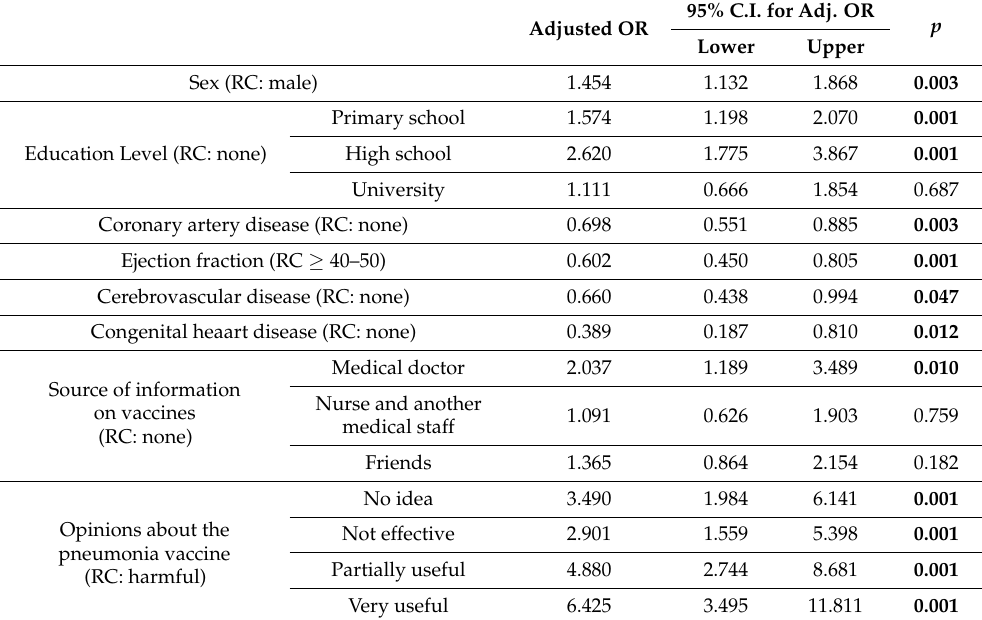
Adjusted effects of risk factors found to be significant by univariate analysis on vaccination